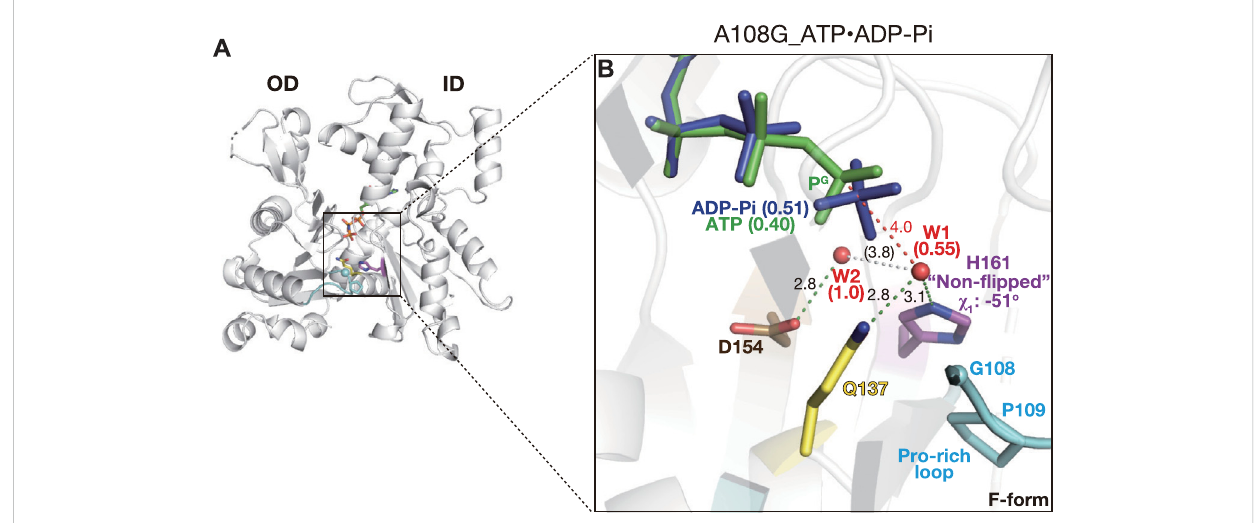
Structure of A108G_ATP · ADP-P i . (A) Overall structure of A108G_ATP · ADP-P i (back view). (B) Close-up view of the active site. This mutant contains both ADP-P i (blue) and ATP (green) in the active site, consistent with a partial hydrolysis reaction that occurred during the crystallization process. W1 has partial occupancy and is absent in the post-hydrolyzed “ ATP-Pi state ” conformer. The occupancy of nucleotides and W1/W2 is indicated in